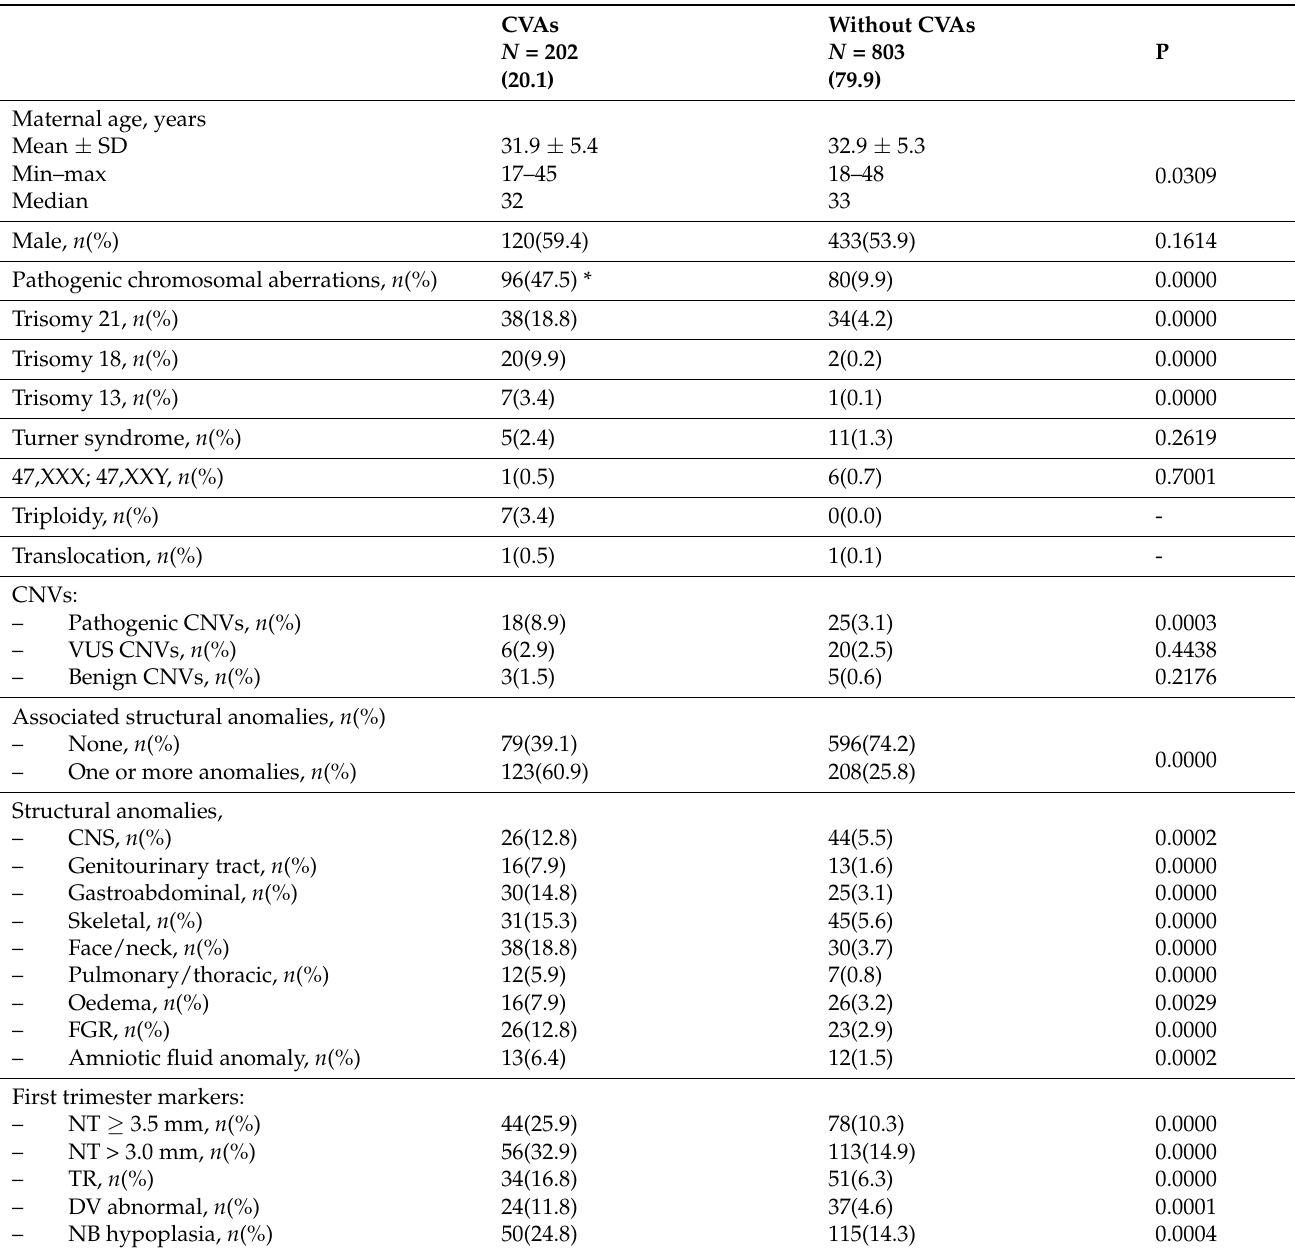
Table 2. Numerical chromosomal aberrations, copy number variants, and structural anomalies among 1005 fetuses with and without cardiovascular anomalies